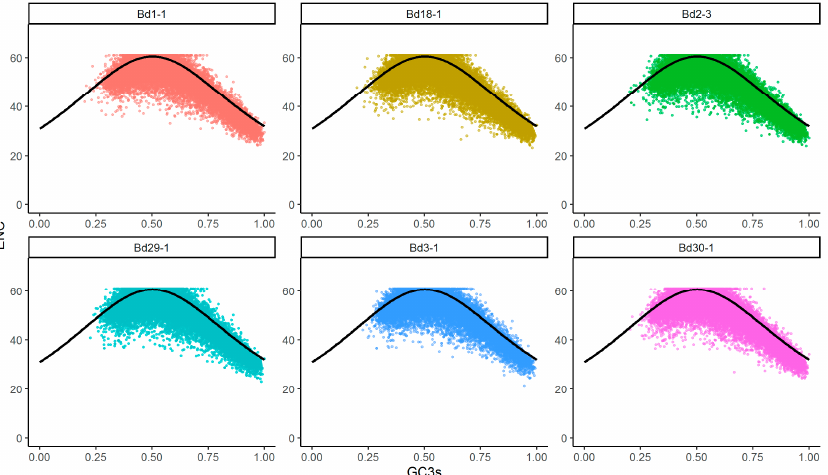
Figure 2. ENC-GC3 plots of the six B. distachyon genomes. The black solid lines indicate the expected ENC values.